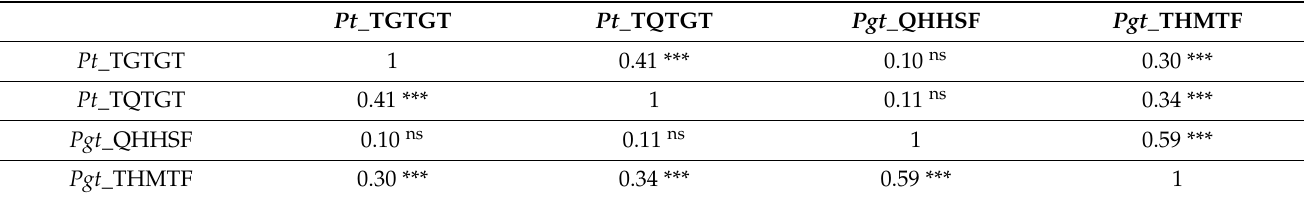
Table 4. Correlations among seedling resistance to Pt races TGTGT and TQTGT and Pgt races QHHSF and